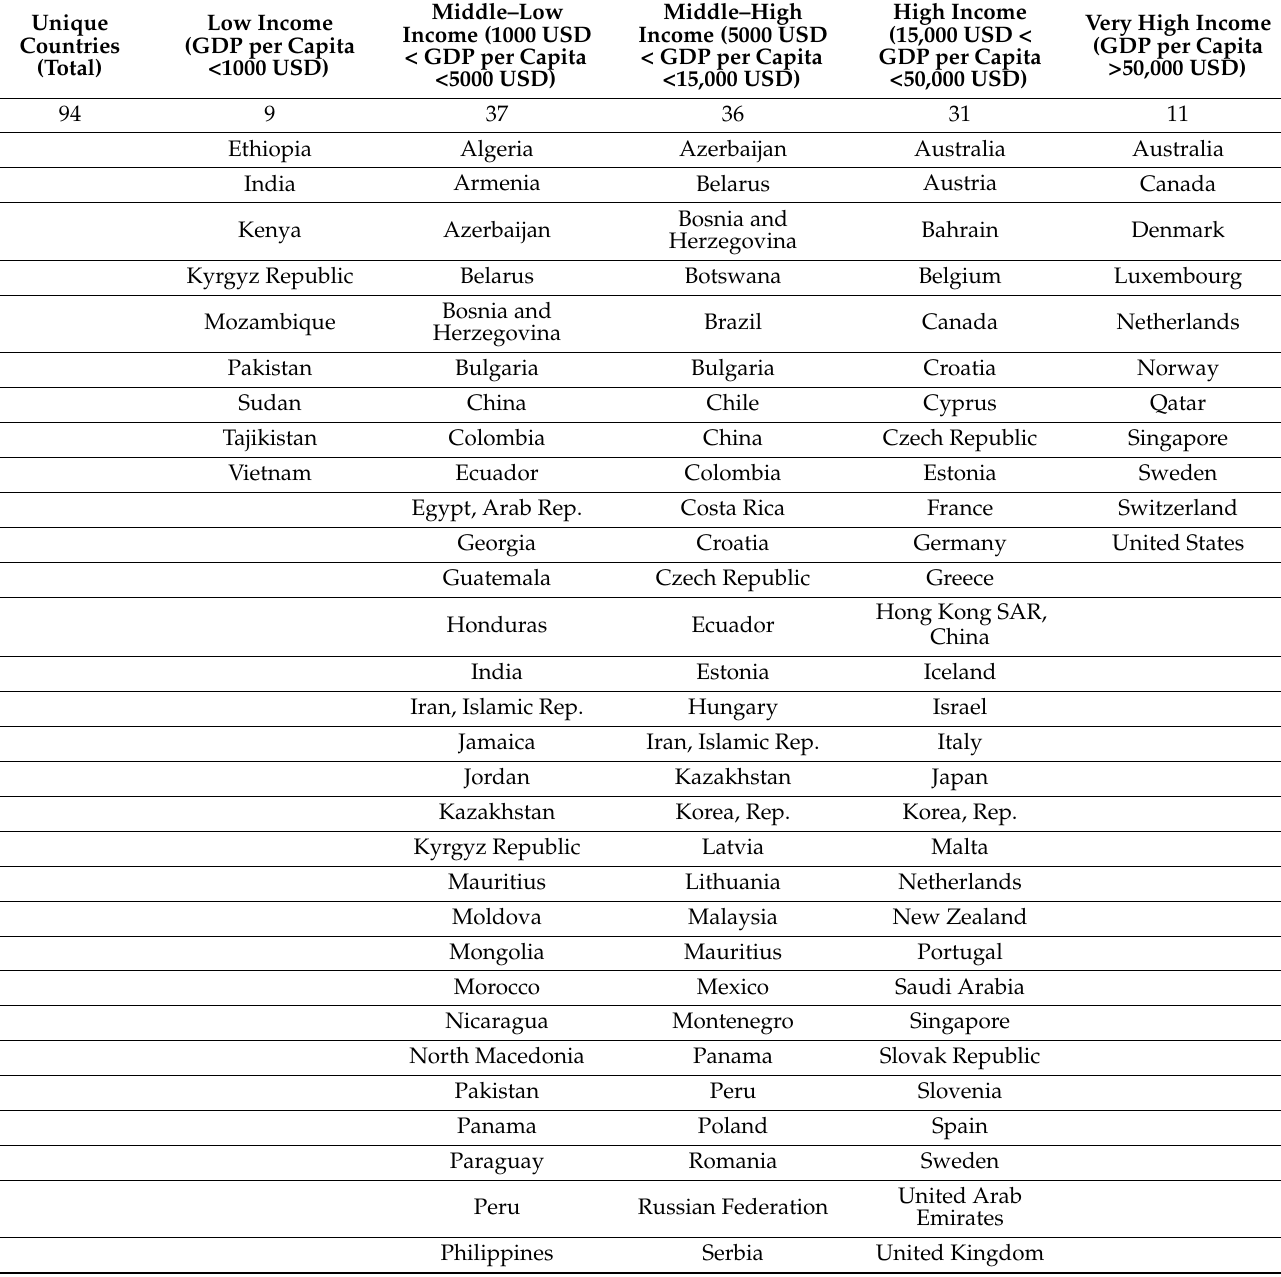
Table A1. List of the Countries in Each Income